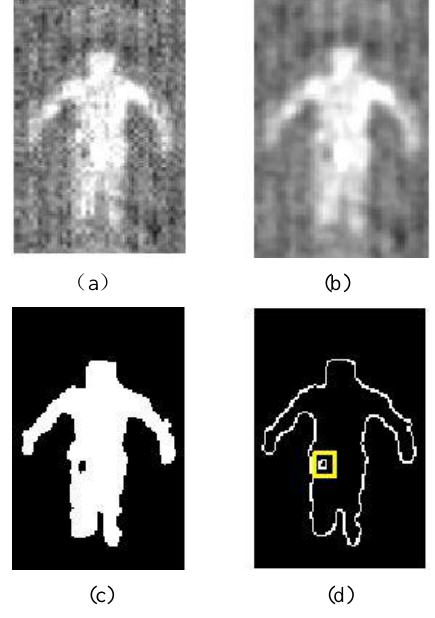
Figure 6. Figure (a), (b), (c) and (d) represent the results of wavelet fusion, mean filter, threshold segmentation and edge detection respectively.